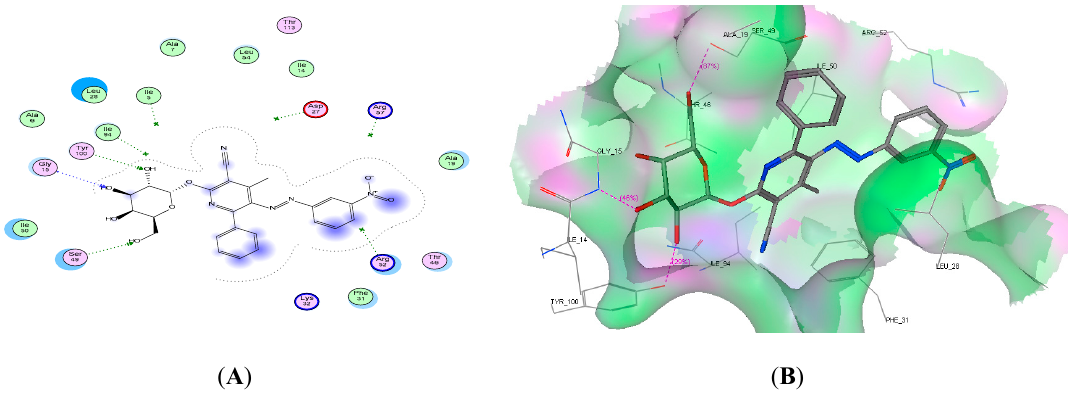
Figure 3. ( A ) 2D interactions of compound 9 d with the DHFR binding site. ( B ) 3D interactions of compound 9 d with the DHFR binding site.